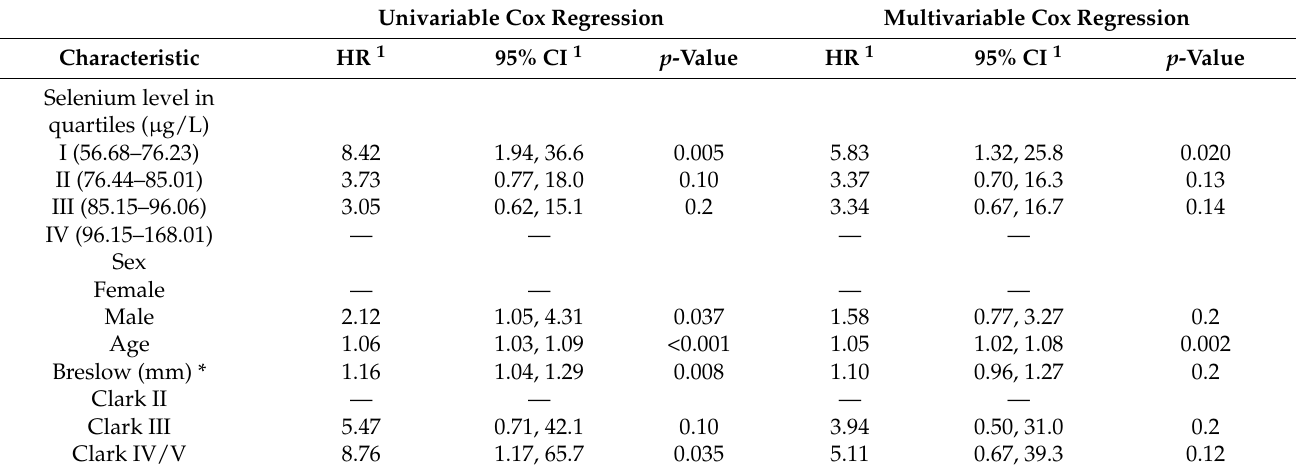
Table 3. Univariable and multivariable Cox proportional hazard models for given factors for 375 melanoma patients. Univariable Cox Regression Multivariable Cox Regression